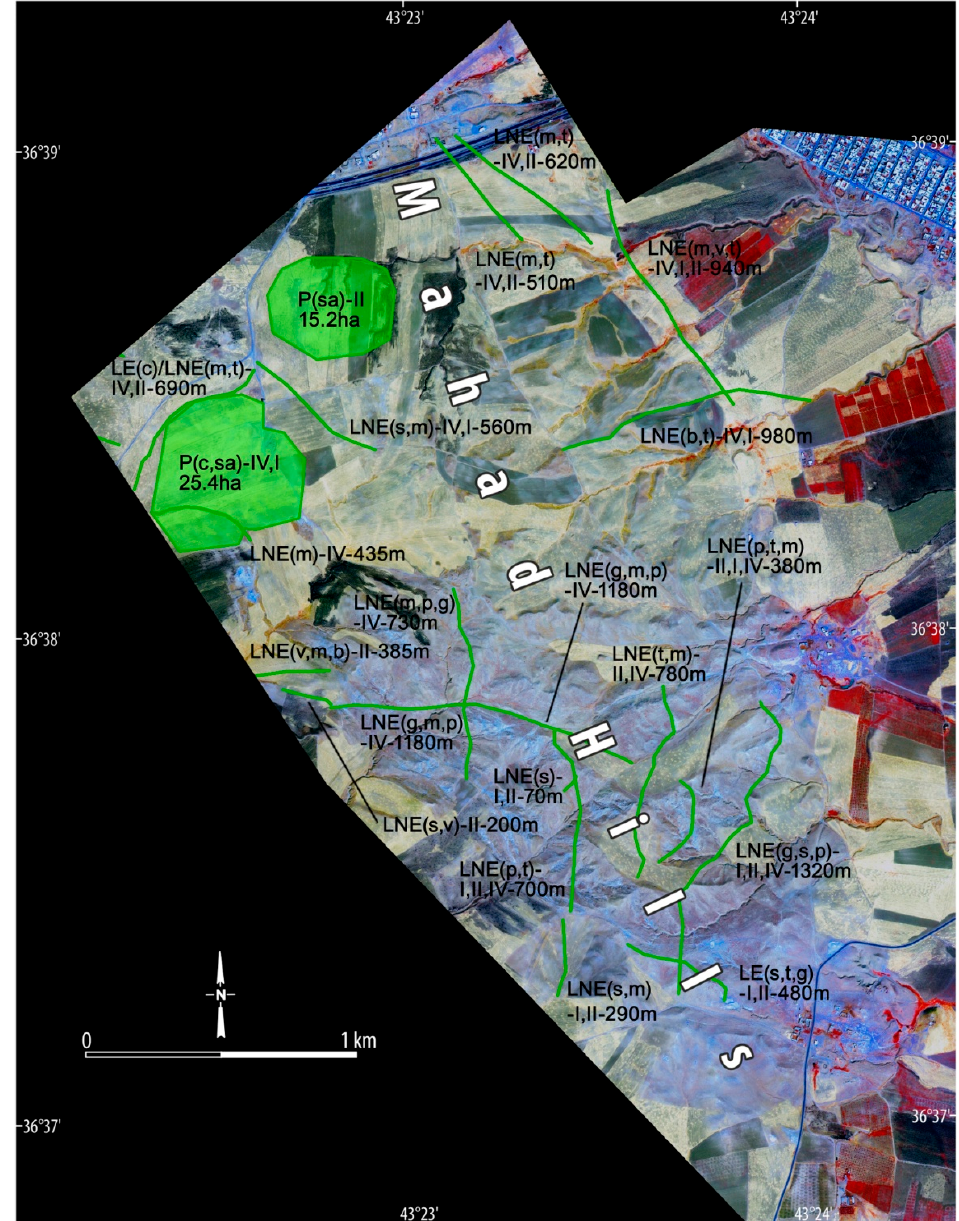
Figure 12. Polygon and linear structures located on the Mahad hills. Abbreviations refer to the most important photointerpretation features for a given indicator, presented in Tables 2 and 3. Roman numerals indicate seasons when the photointerpretation features were best represented: I—winter; II—spring; and IV—autumn. Background image WV2, FCC 158 IHS (ID10300100388F8C00). WorldView ‐ 2 © 2014 DigitalGlobe, Inc., Westminster, Colorado, USA.